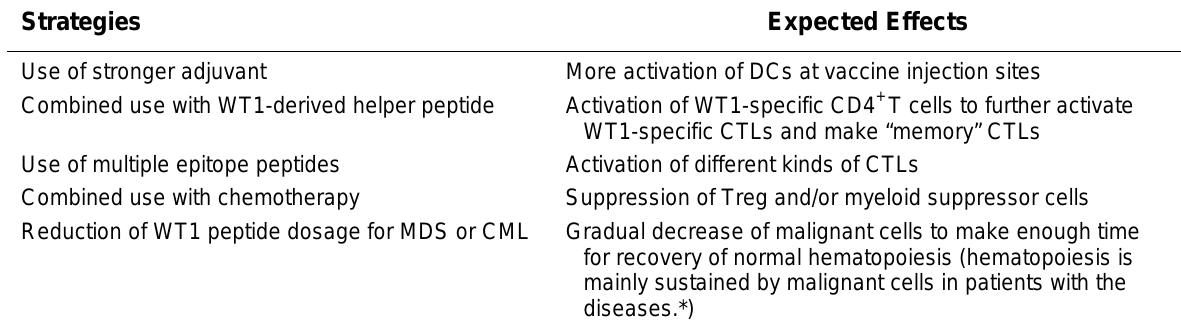
Immunological Aspect-Based Strategies to Improve WT1 Peptide Vaccine Strategies Expected